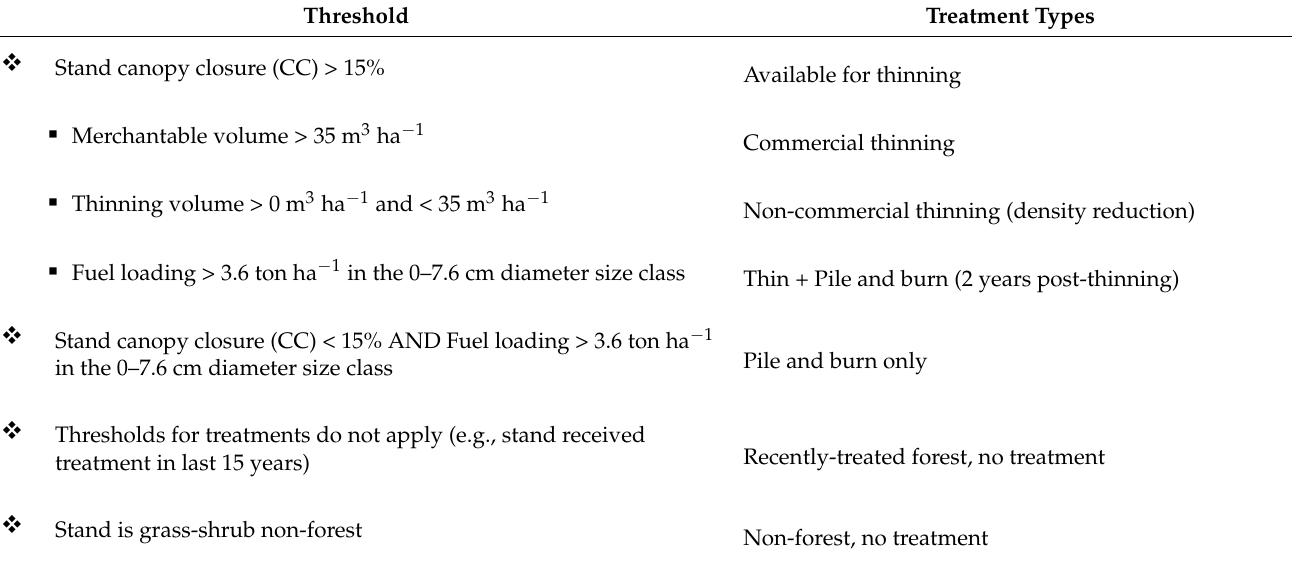
Table 1. Stand thresholds used to determine treatment types, as described by Belavenutti et al. (2021), modified for fuel breaks by thinning down to 15% canopy closure.